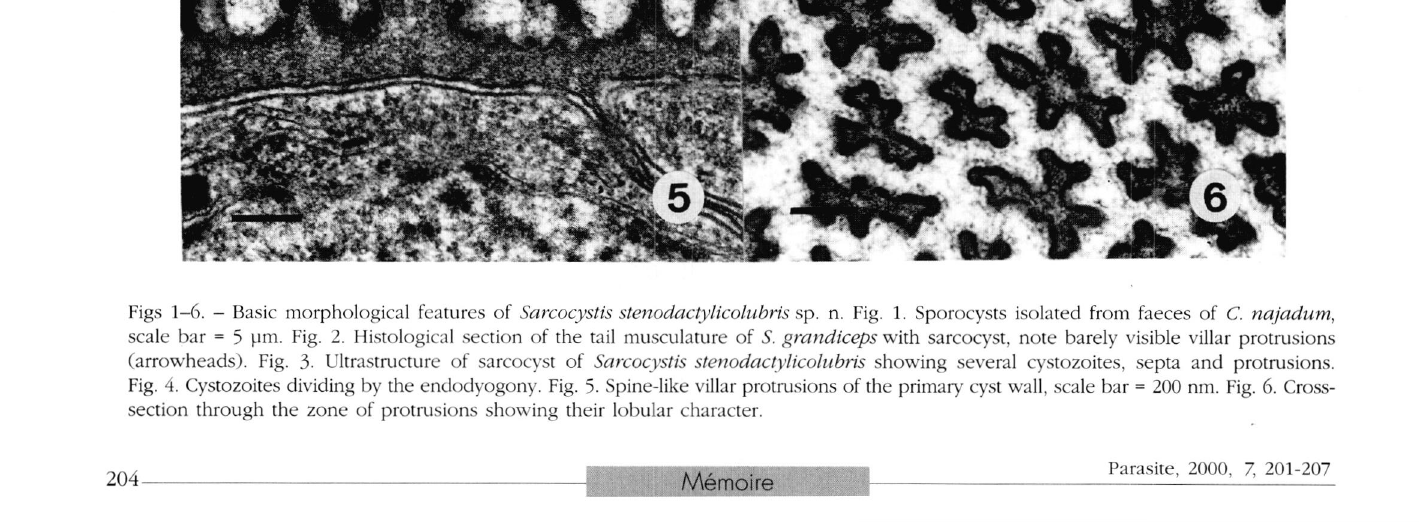
204 Parasite, 2000, 7, 201-207